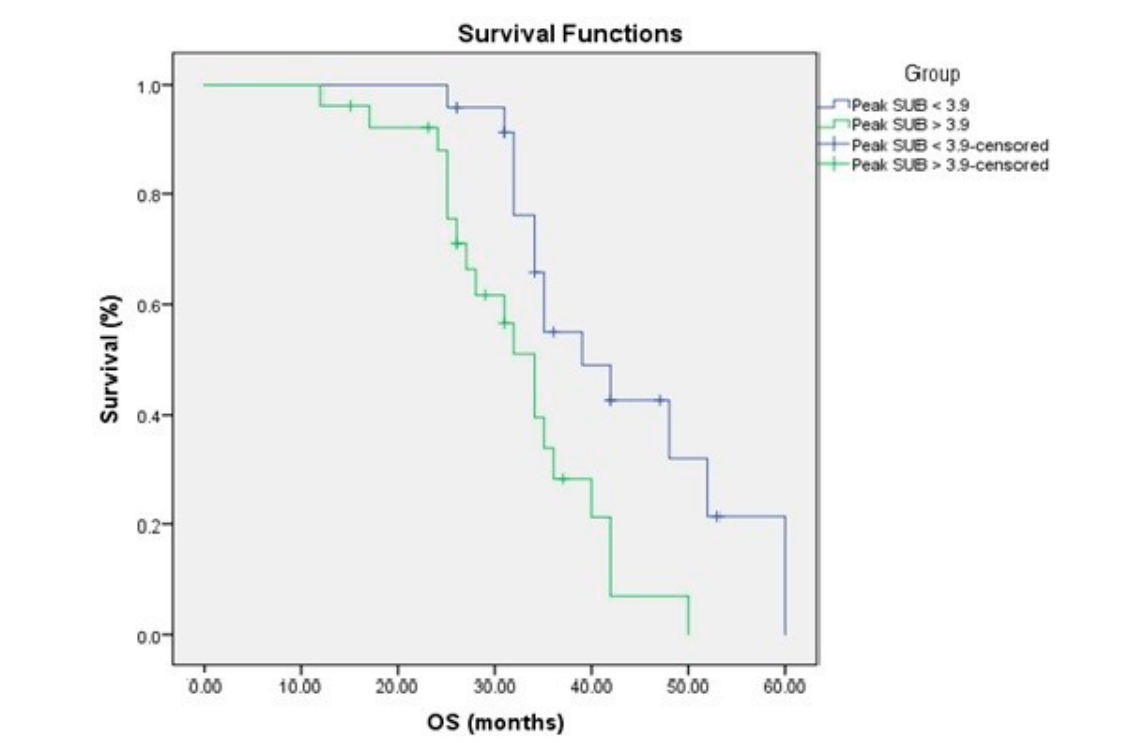
Figure 5. The overall survival in relation to FDG uptake. Table 5. Survival time means and medians